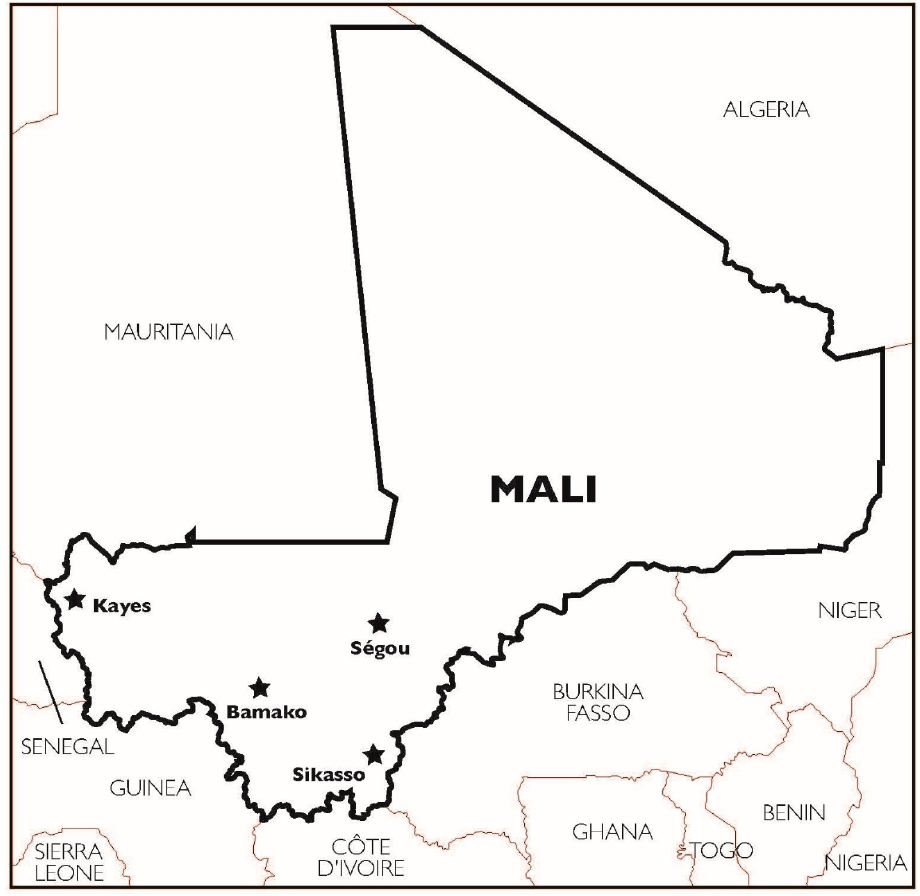
Figure 1. Mali’s four largest urban cities (Source: Authors, 2018).